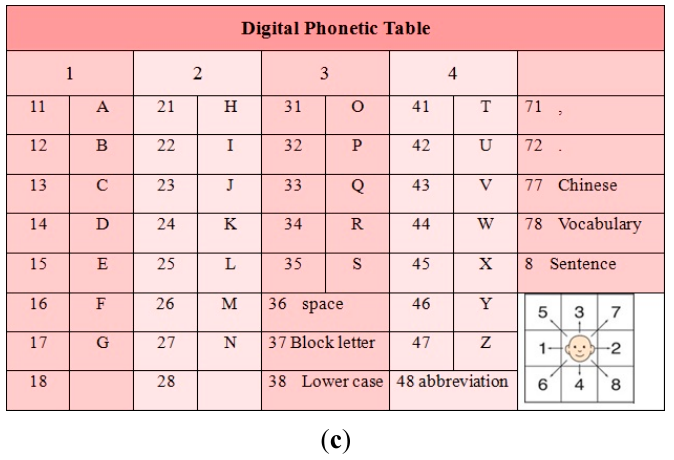
Figure 5. The flexible designs of frequently used ( a ) Chinese and ( b ) English sentences, and ( c ) English digital phonetic table of a numeric human–machine interface .